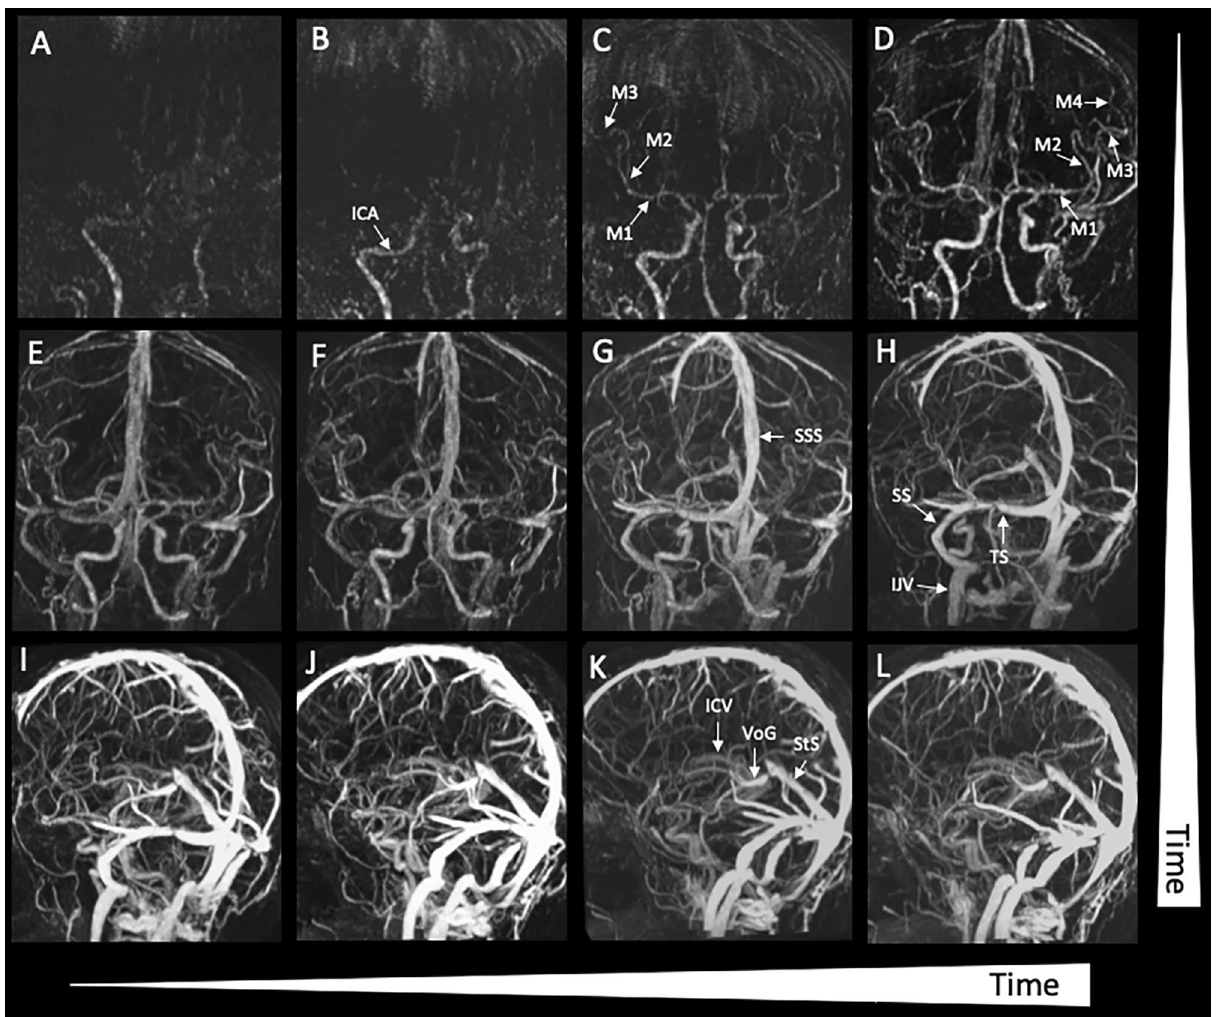
Figure 2. GRASP MRI from a 63-year-old woman imaged for headache reconstructed as time-resolved 3D MRA MIP images. Selected maximum intensity projections (MIPS) reconstructed from subtracted axial brain GRASP MRI using a 5 spoke reconstruction ( A – L ). 3D MIPs are rotated about the z-axis for illustrative purposes, exhibiting high-resolution, nearly 1–2 s resolved dynamic bolus passage through the cerebrovascular system, spanning earliest arterial through venous drainage phases. Arterial segments are labeled, including the internal carotid artery (ICA), middle cerebral artery (MCA) segments (M1, M2, M3, M4, and M5), and venous structures, including the superior sagittal sinus (SSS), transverse sinus (TS), straight sinus (SS), internal jugular vein (IJV), internal cerebral veins (ICV), vein of Galen (VoG), and straight sinus